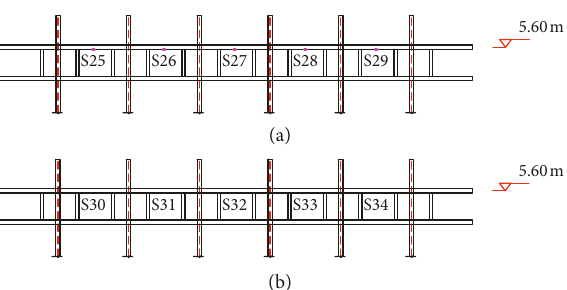
Figure 11: Layout of strain gauges on horizontal rods in Model 2. (a) A-axis horizontal beam. (b) C-axis horizontal beam.